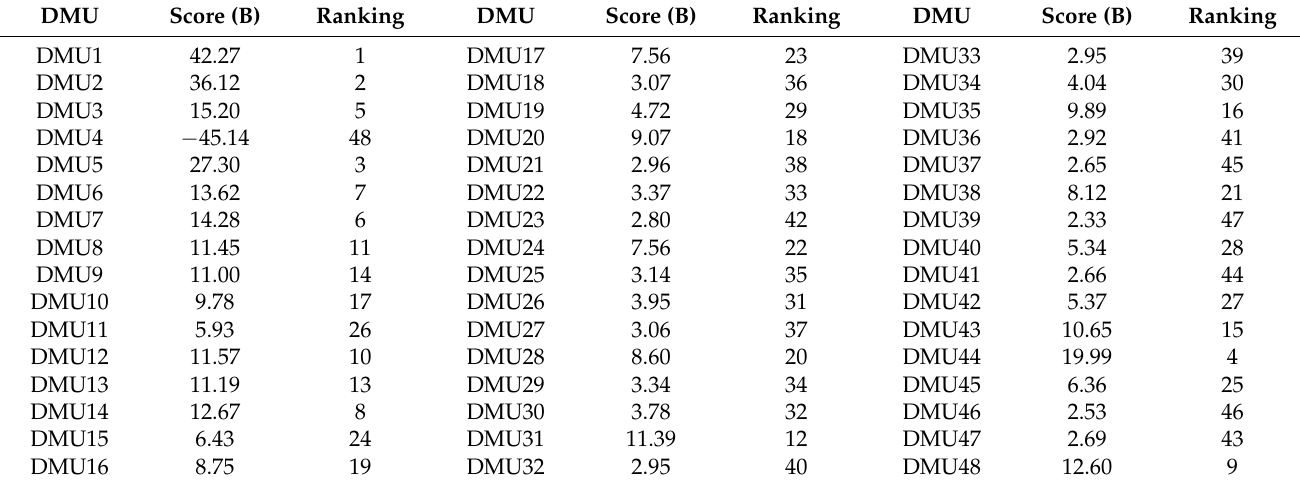
Table 2. Score and ranking of DMUs in the research sample, according to the BVM.